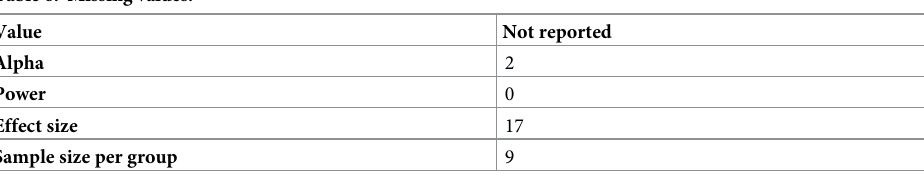
Table 6. Missing values. Value Not reported Alpha 2 Power 0 Effect size 17 Sample size per group 9 Frequencies of missing values in publications with reported sample size calculation.